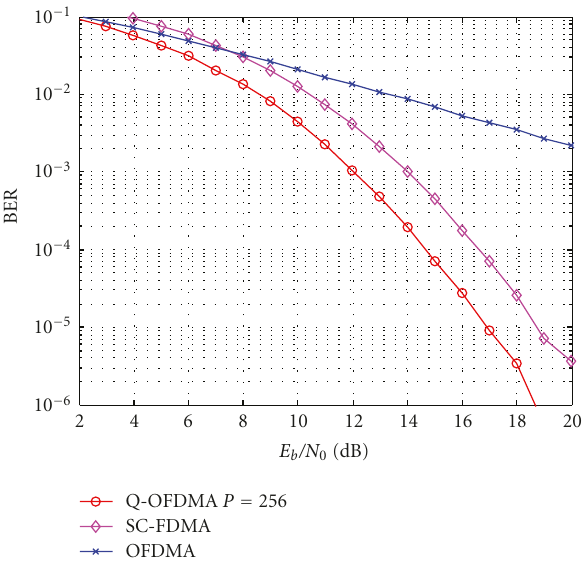
Figure 4: BER comparison of uncoded systems with QPSK modulation under CM2 channel model, where N = 1024.